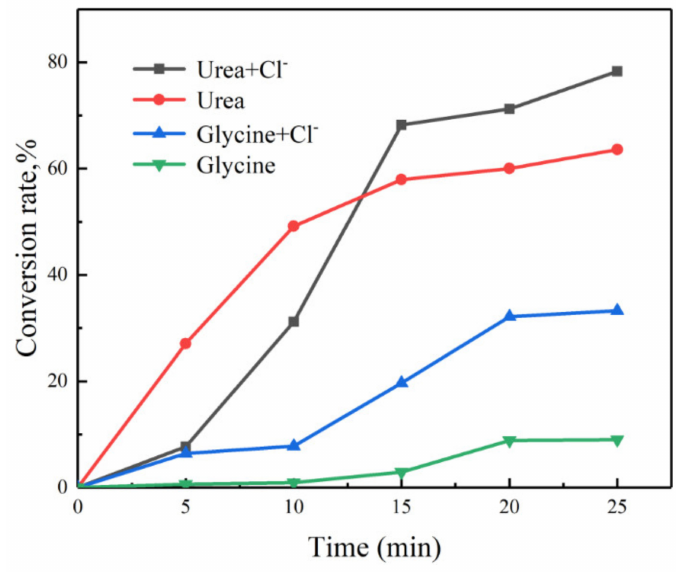
Figure 8. Effect of Cl − on the digestion of urea and glycine.